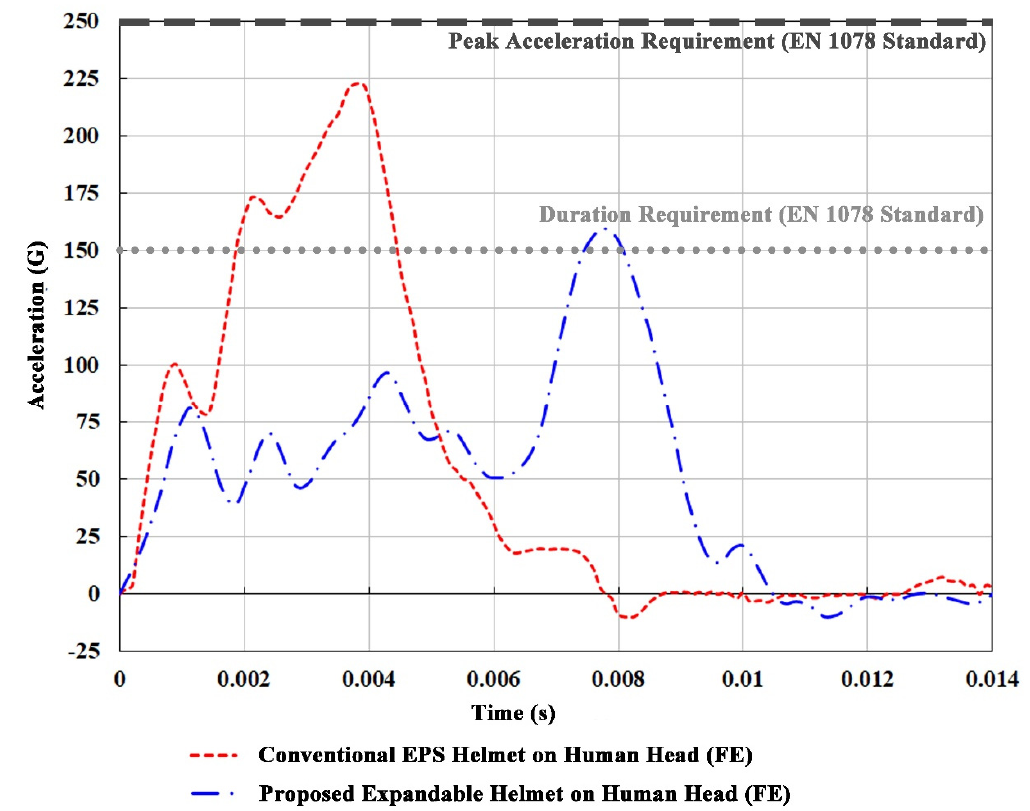
Figure 3. The acceleration histories at the CG of the head model for the EPS helmet and the proposed expandable helmet.